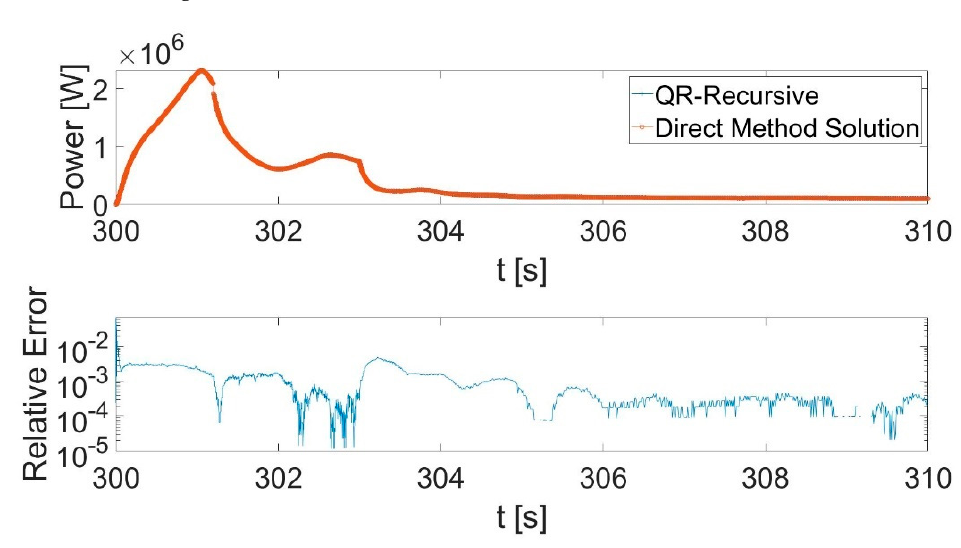
Figure 13. Testcase#1: ( Top ) the power dissipated during the transient in all passive structures. ( Bot- tom ) the relative error of the QR-recursive based method with respect to the Direct computation.